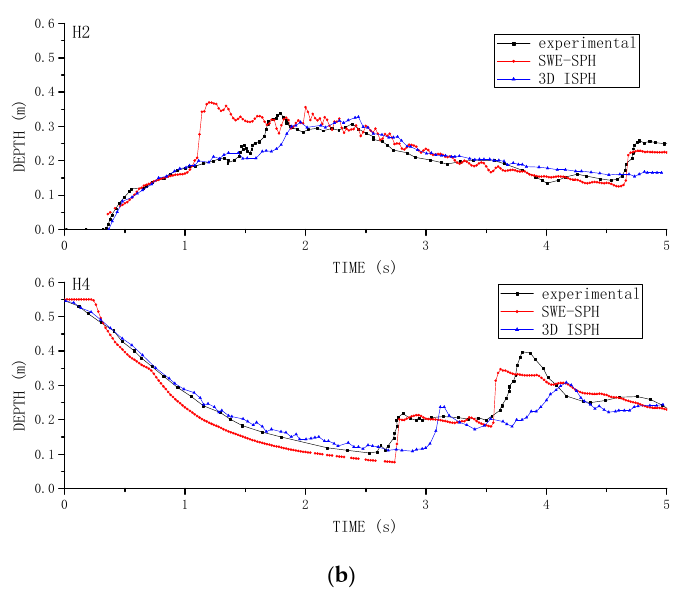
Figure 10. Time histories of dam break flow surface profile at gauging points between SWE-SPHysics results, experimental data [21], VOF [21] and 3D ISPH [22] computations: ( a ) VOF data; and ( b ) 3D ISPH data.